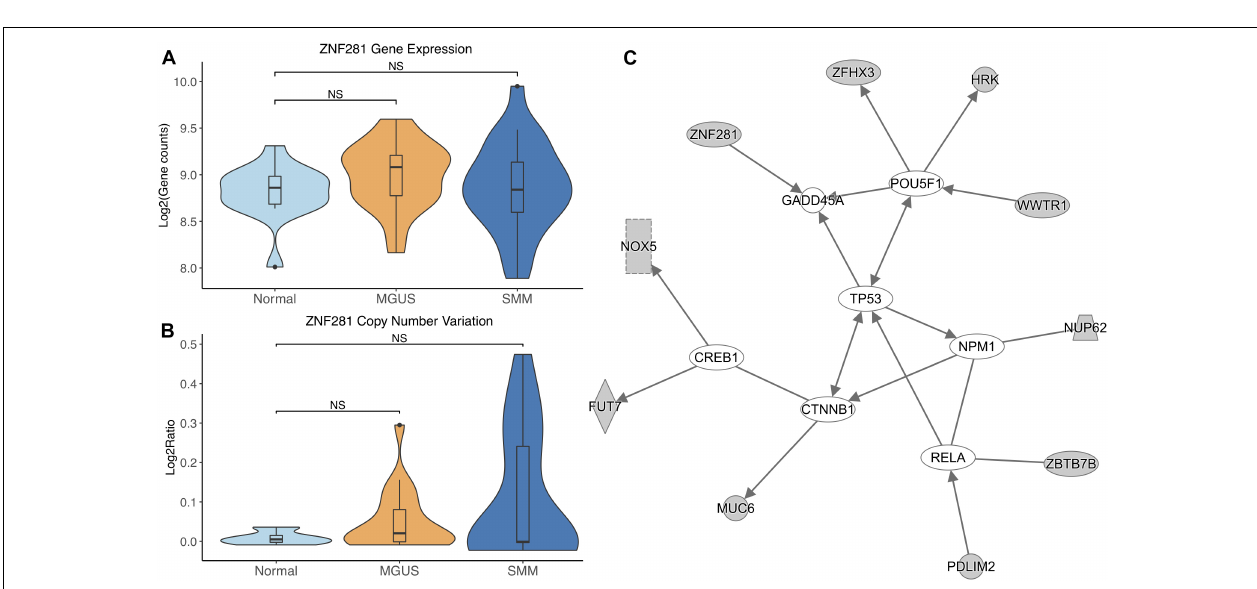
FIGURE 5 | (A) TCF4 expression across sample groups. Mann–Whitney tests showed significant differential expression between Normal and MGUS ( p = 3.65E-03) and between Normal and SMM ( p = 1.49E-02). (B) Observations of TCF4 copy number. Mann–Whitney tests showed no significant differences between any groups. (C) A predicted interaction network of TCF4 and its downstream targets. The gray nodes indicate genes from our module and the white nodes are gene interactions defined in IPA. Solid lines between nodes indicate a direct interaction supported by the Ingenuity Knowledge Base. Significance levels: ∗ p ≤ 0.05; ∗∗ p ≤ 0.01; ∗∗∗ p ≤ 0.001.